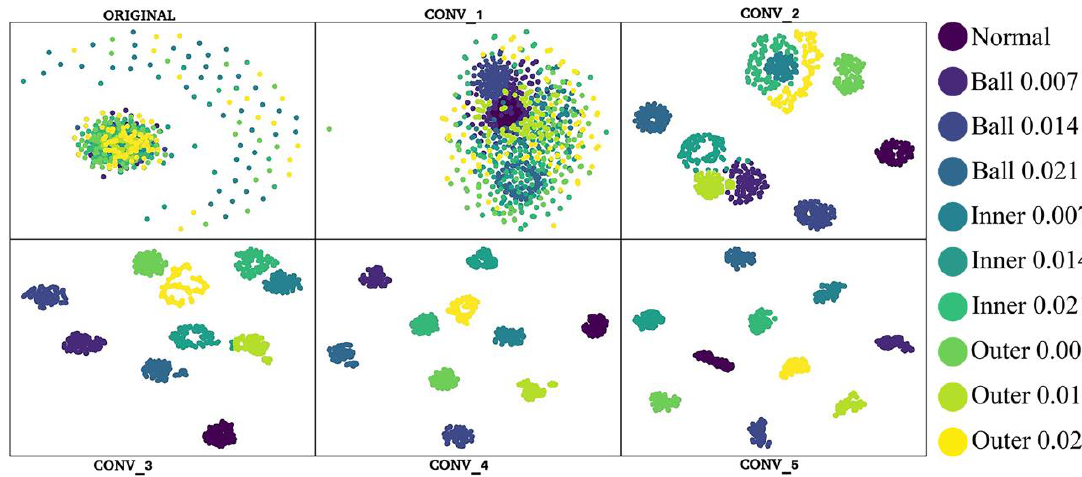
Figure 11. Feature distribution corresponding to number of layers.